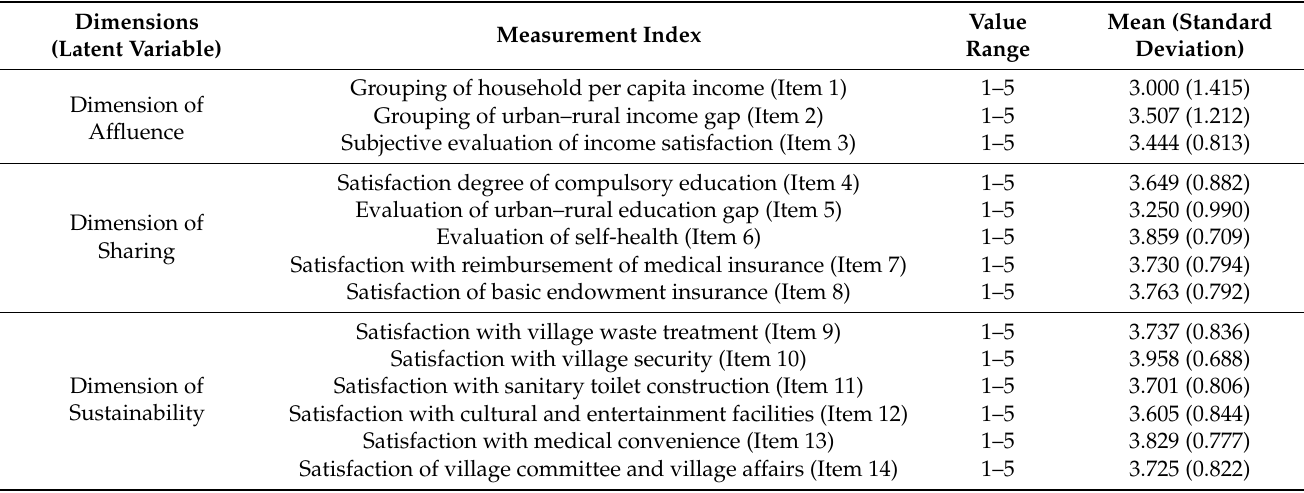
Table 1. Descriptive statistics for the common prosperity indices of rural households.